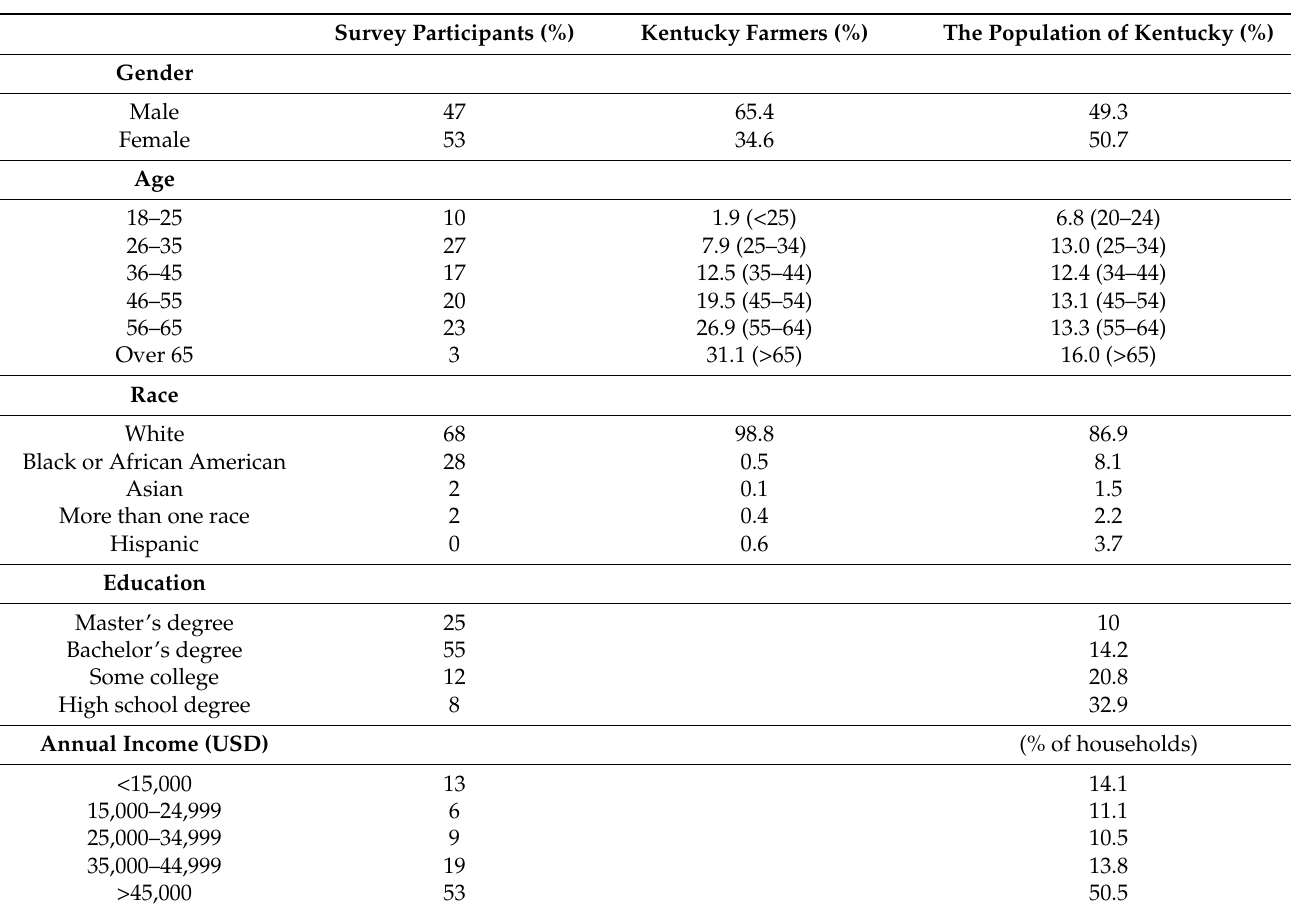
to 43 years. Survey participants differed from Kentucky farmers and the population of Kentucky in many ways (Table 1). Survey participants had a more equal gender split (Chi-squared = 5.560, p = 0.018), were younger (Chi-squared = 44.739, p < 0.001), and more diverse than Kentucky farmers, with more blacks or African American participants (Chi-squared = 607.74, p < 0.001). Survey participants did not differ from residents of Ken- tucky as a whole in terms of gender (Chi-squared = 0.054, p = 0.816), age (Chi-squared = 9.684, p = 0.085), and income (Chi-squared = 2.566, p = 0.633), but were more diverse (Chi-squared Table 1. The demography of survey participants ( n = 40), Kentucky farmers ( n = 123,995) (United States Department of Agriculture National Agricultural Statistics Service), and the population of Kentucky ( n = 4,449,052) (United States Census Bureau). Note: Values in brackets under Kentucky farmers and the population of Kentucky represent the different age groupings used in data collection by the sources. Survey Participants (%) Kentucky Farmers (%) The Population of Kentucky (%) 47 65.4